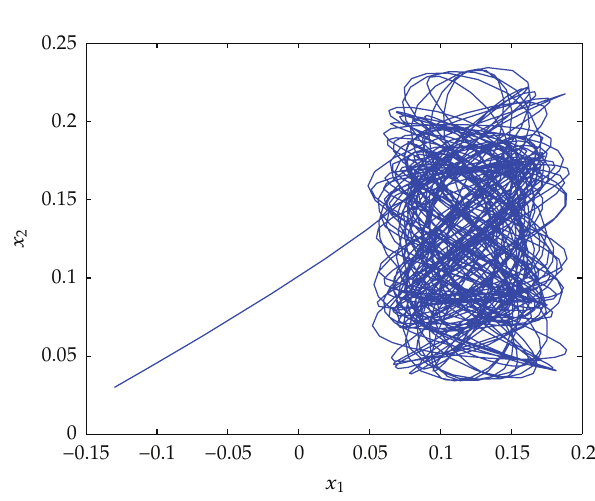
Figure 2: Phase response of state variables x 1 ,x 2 in Example 4.1.